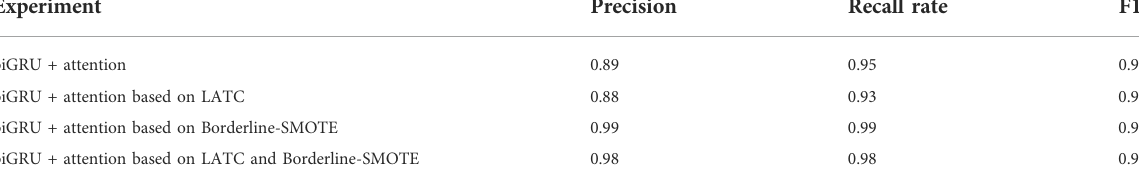
TABLE 13 Average of evaluation indexes of different